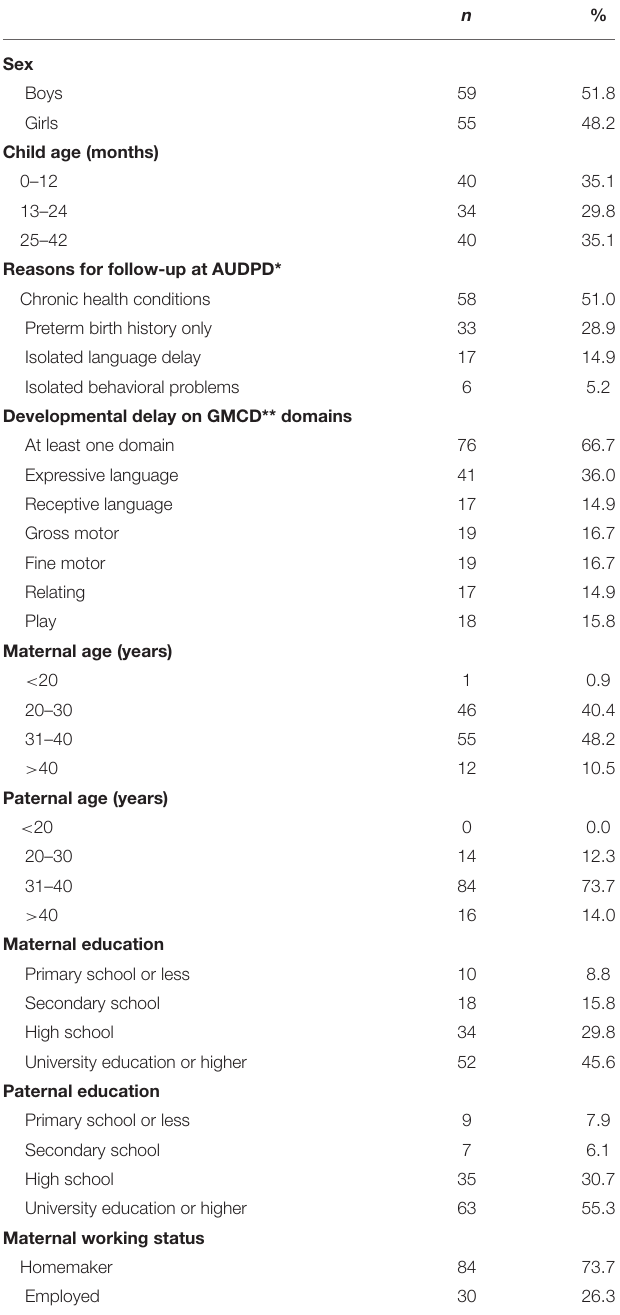
TABLE 1 | Sociodemographic, health, and developmental characteristics ( N =